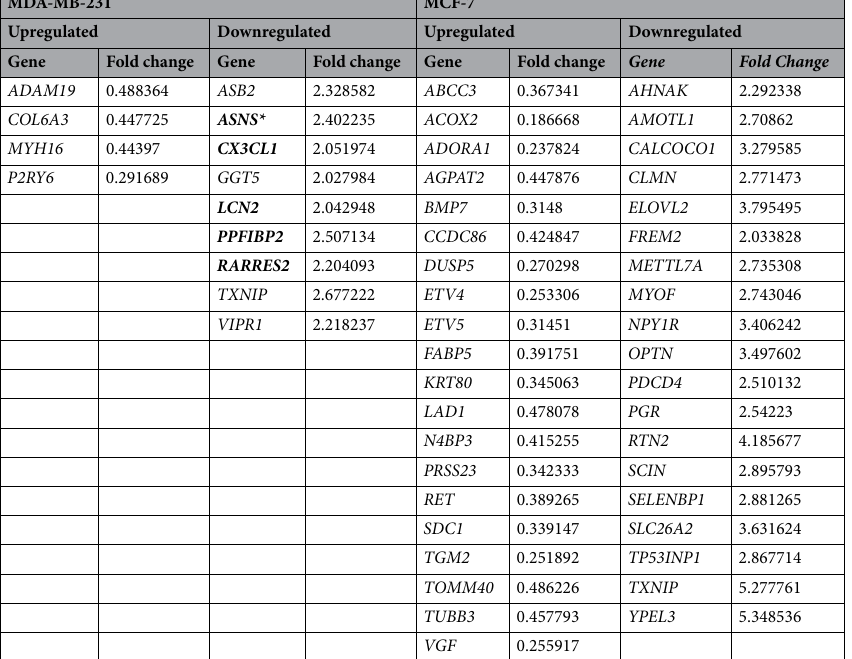
Table 1. Differentially expressed genes in MDA-MB-231 and MCF-7 cells after treatment with EqMDEC-CM, as identified by RNA sequencing. * Bolded genes: genes that were confirmed to be differentially expressed in MDA-MB-231 by qRT-PCR as